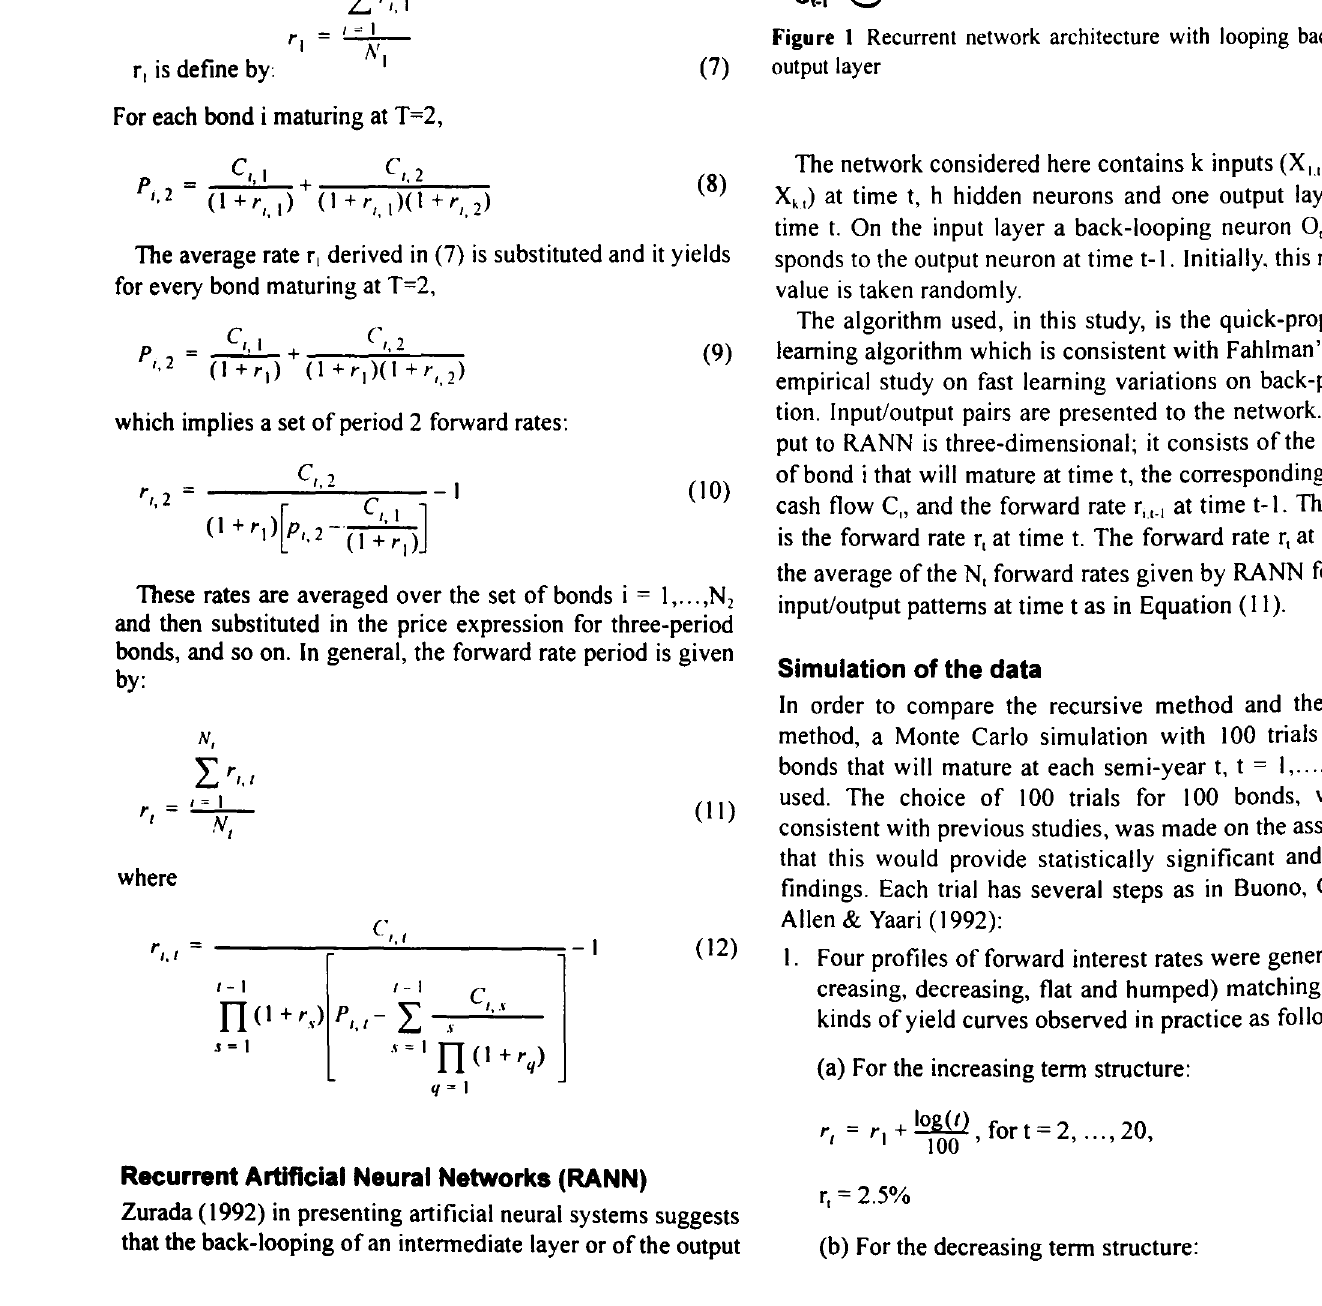
Figure I Recurrent network architecture with looping back of the output